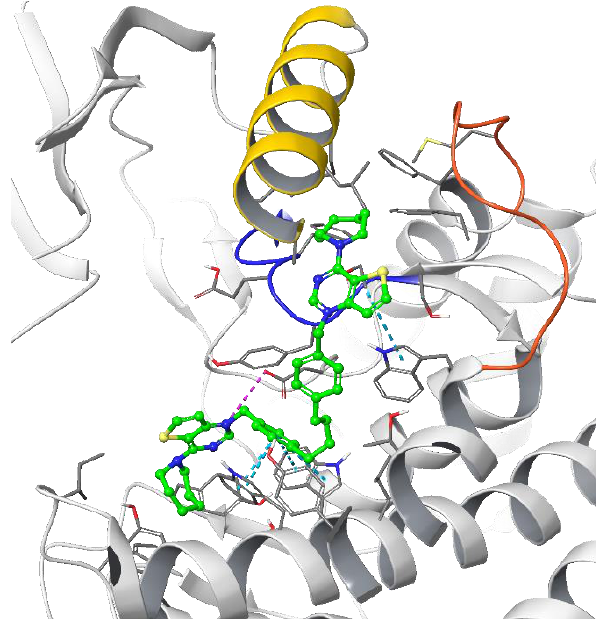
Figure 4 . Putative binding pose of the most potent compound Fa-29 (in green) into 4CG8 crystal structure. Ionic and π-π stacking interactions are highlighted as dashed magenta and cyan lines, respectively. The choline binding motif is represented with a blue ribbon, the B helix is in yellow and the loop connecting helices D and E is represented in orange.